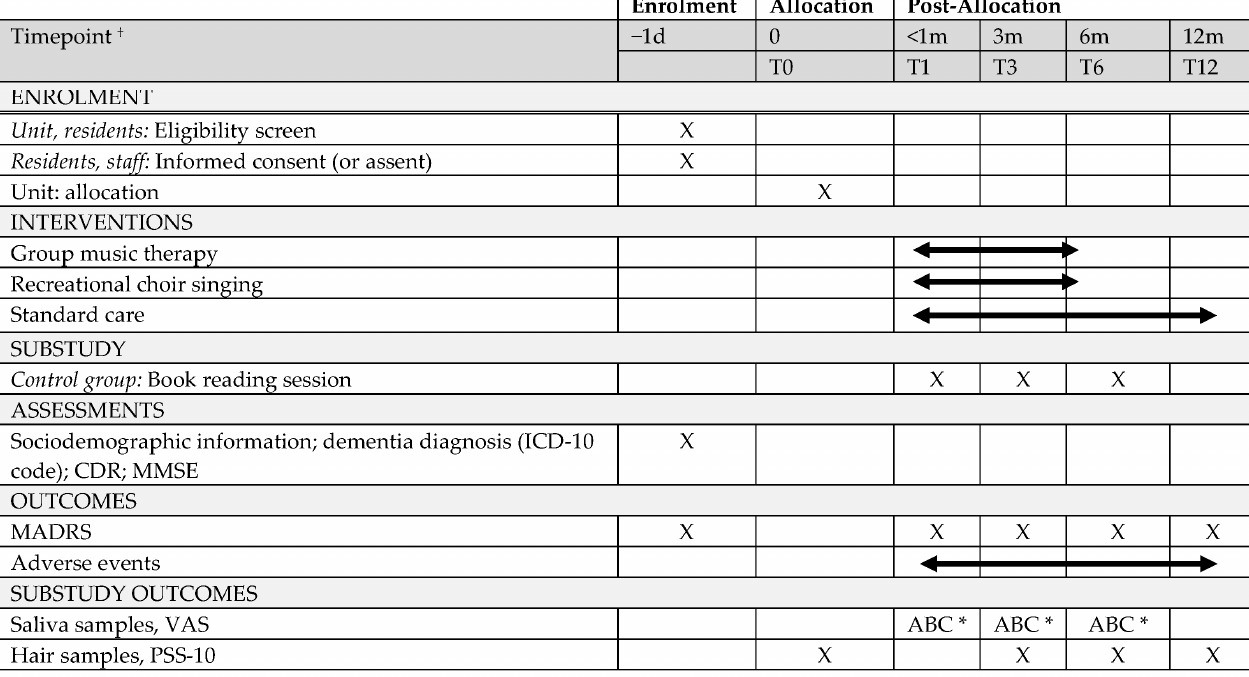
Figure 2. Schedule of enrolment, interventions, and assessments of the exploratory substudy